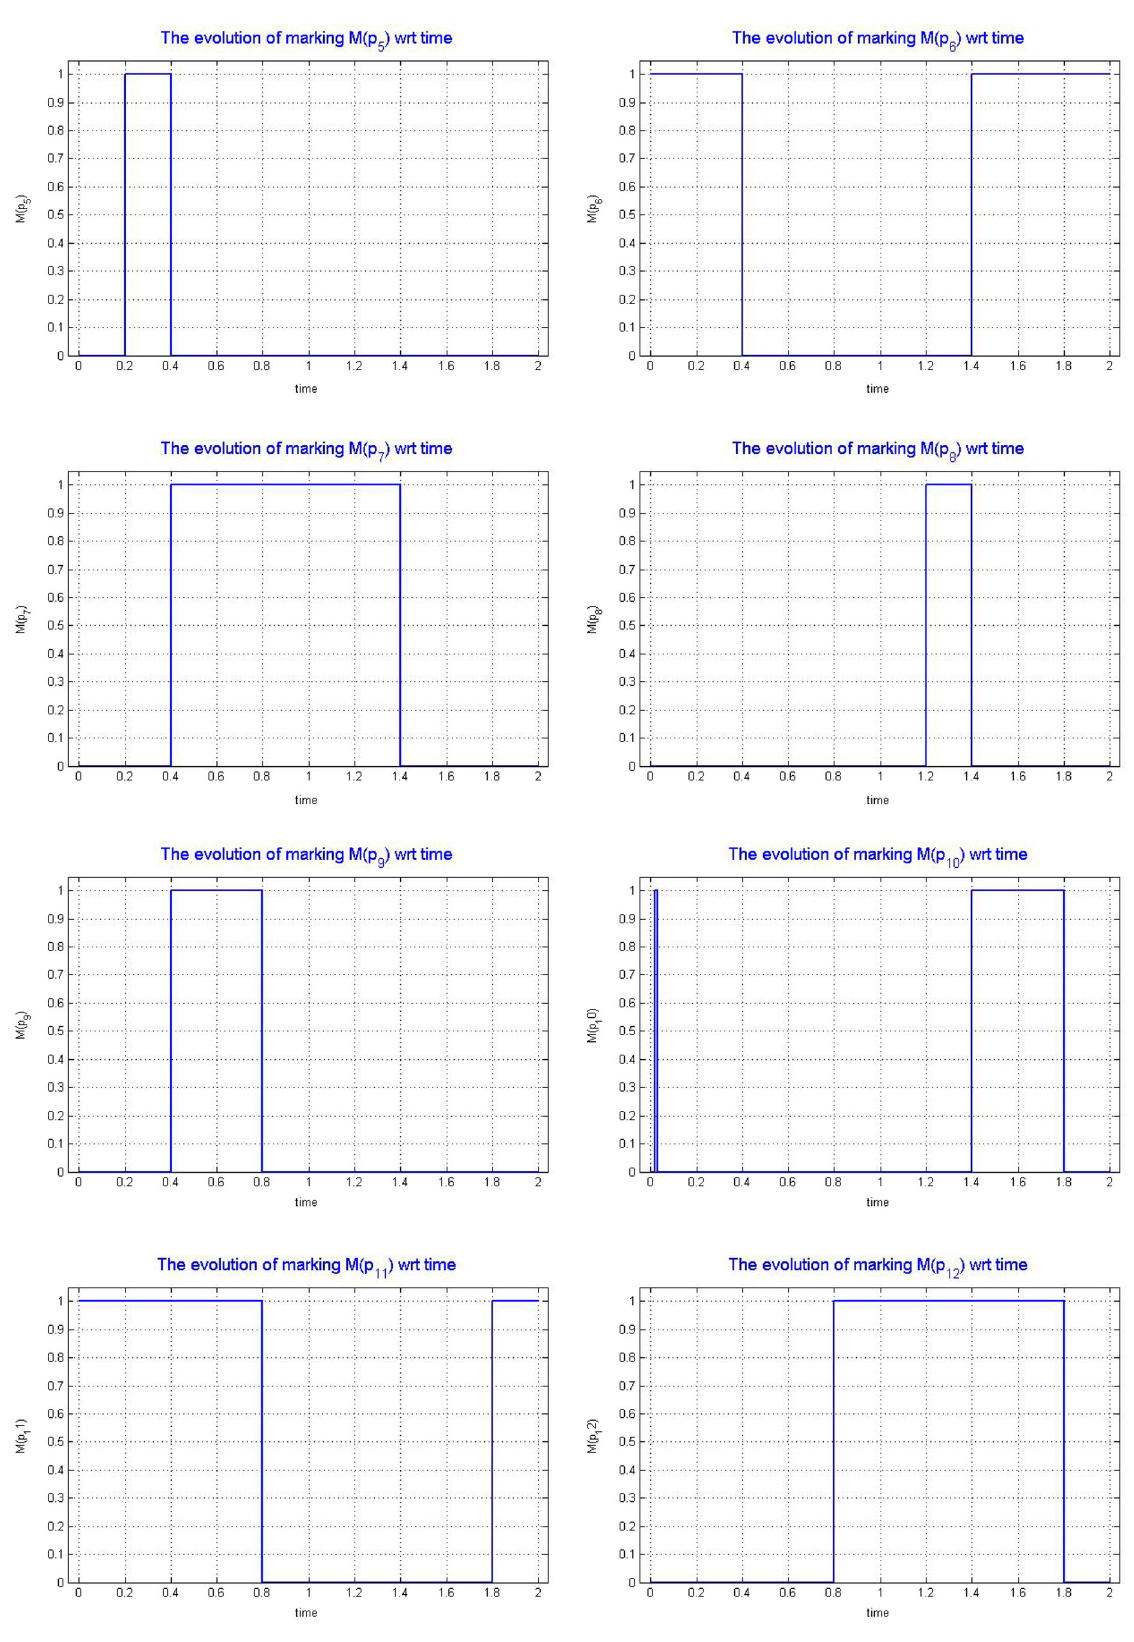
Fig. 11 The courses of marking the places p 5 − p 12 wrt. time. The marking of p 10 is directly influenced by t f